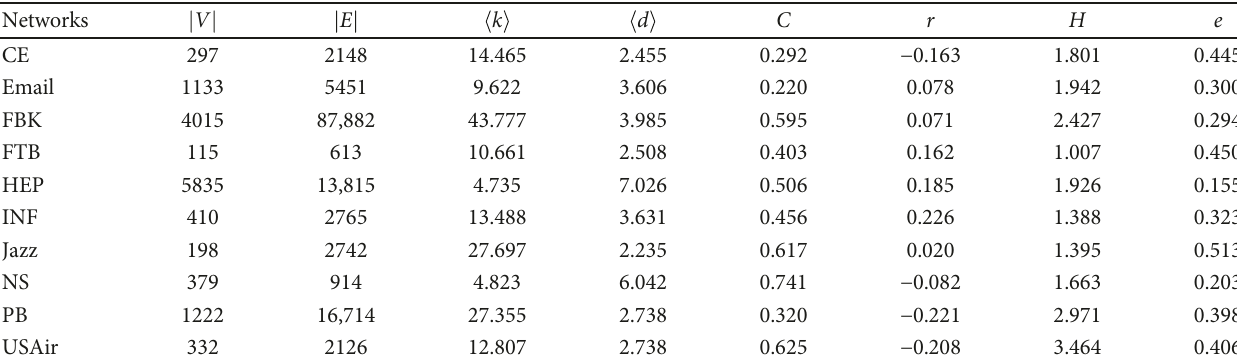
Table 2: The basic statistics of the giant components of the 10 networks. V and E are the total numbers of nodes and edges, respectively. k and d present the average degree and the average shortest distance, respectively. C and r indicate the clustering coe ffi cient [45] and assortative coe ffi cient [54], respectively. H is the degree heterogeneity [17], and e is the network e ffi ciency [55]. Networks V E k d